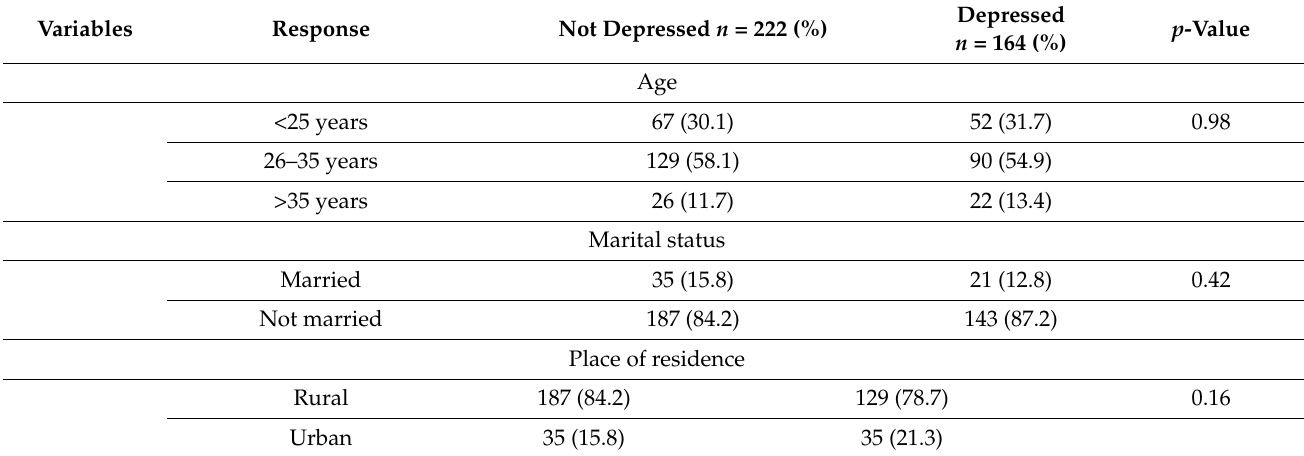
Table 4. Univariate analysis of sociodemographic factors and PND